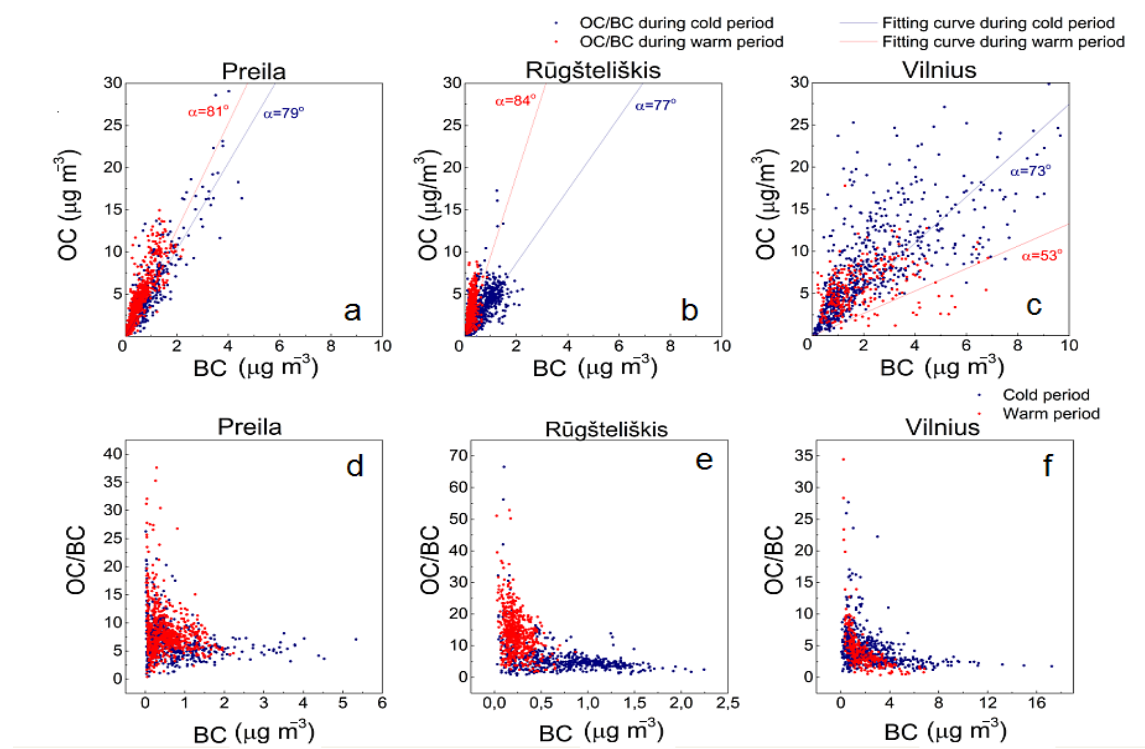
Figure 4. Scatter plots of OC versus BC and OC/BC versus BC in ( a , d ) coastal/marine (Preila), ( b , e ) rural (R ū gšteliškis) and ( c , f ) urban background (Vilnius) environments during cold (blue) and warm (red)